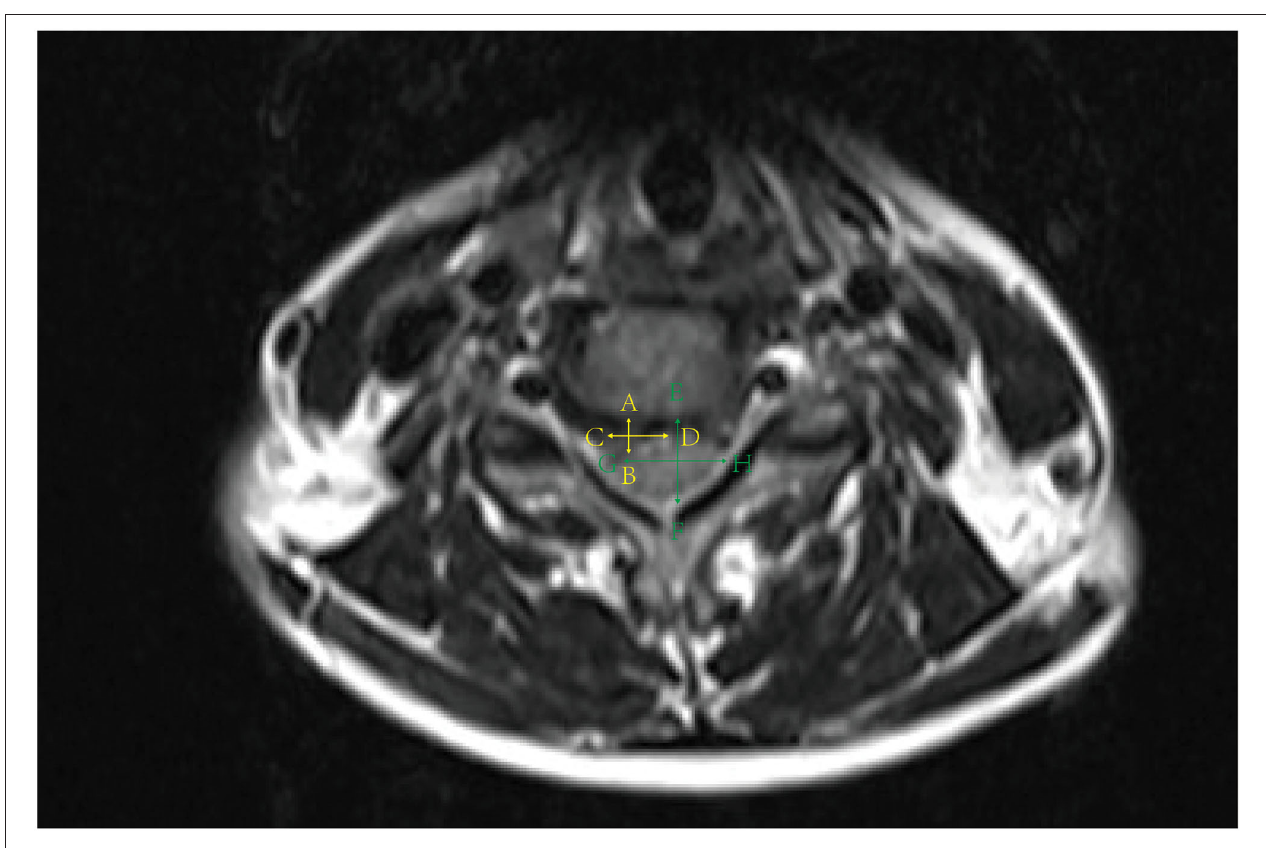
FIGURE 3 | Measurement of disk herniation